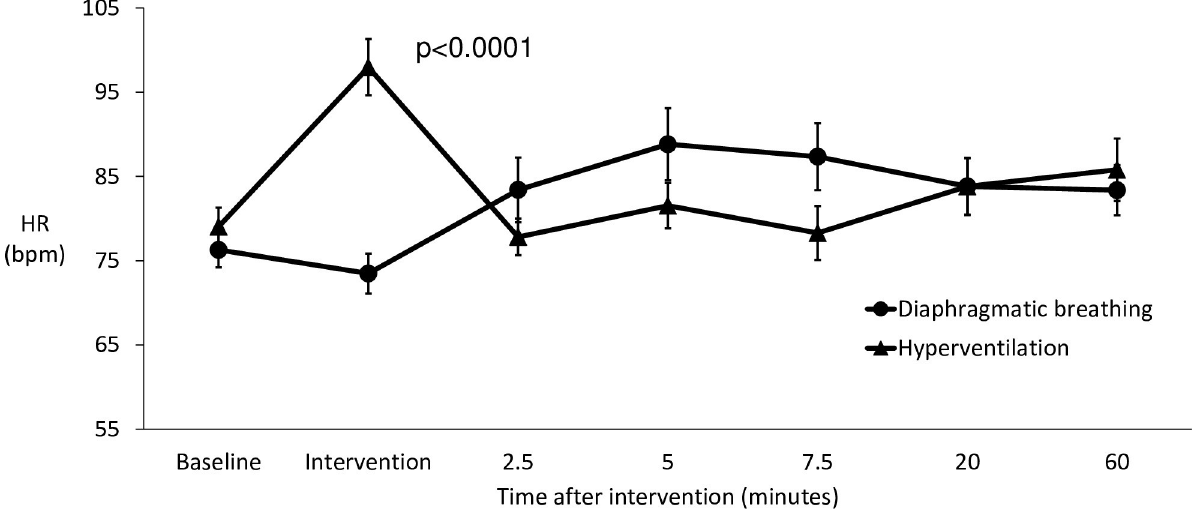
Fig 3. The effects of hyperventilation versus diaphragmatic breathing on the heart rate of all participants in the first 60 minutes.